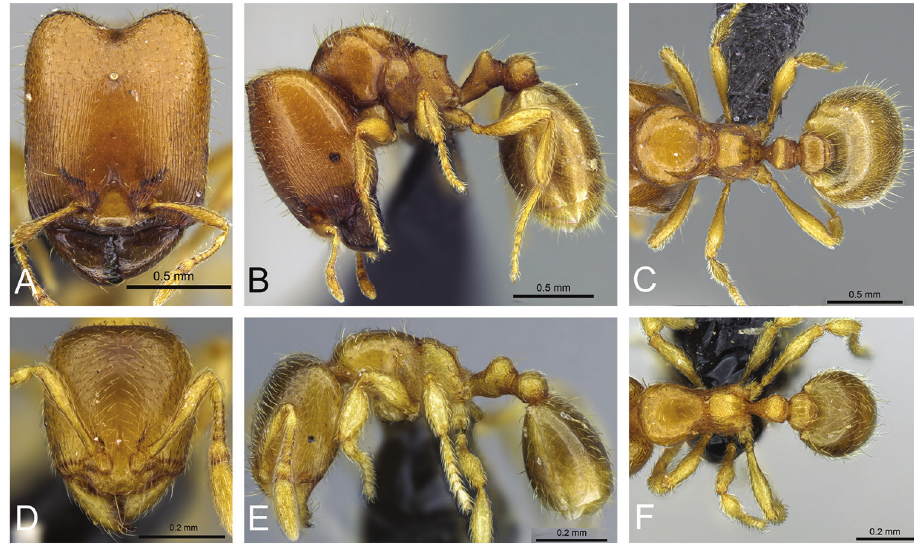
Figure 55. Carebara omasi –holotype. Major worker, CASENT0028870: A head in full-face view B body in profile view C body in dorsal view. Minor worker, CASENT0028947: D head in full-face view E body in profile view F body in dorsal